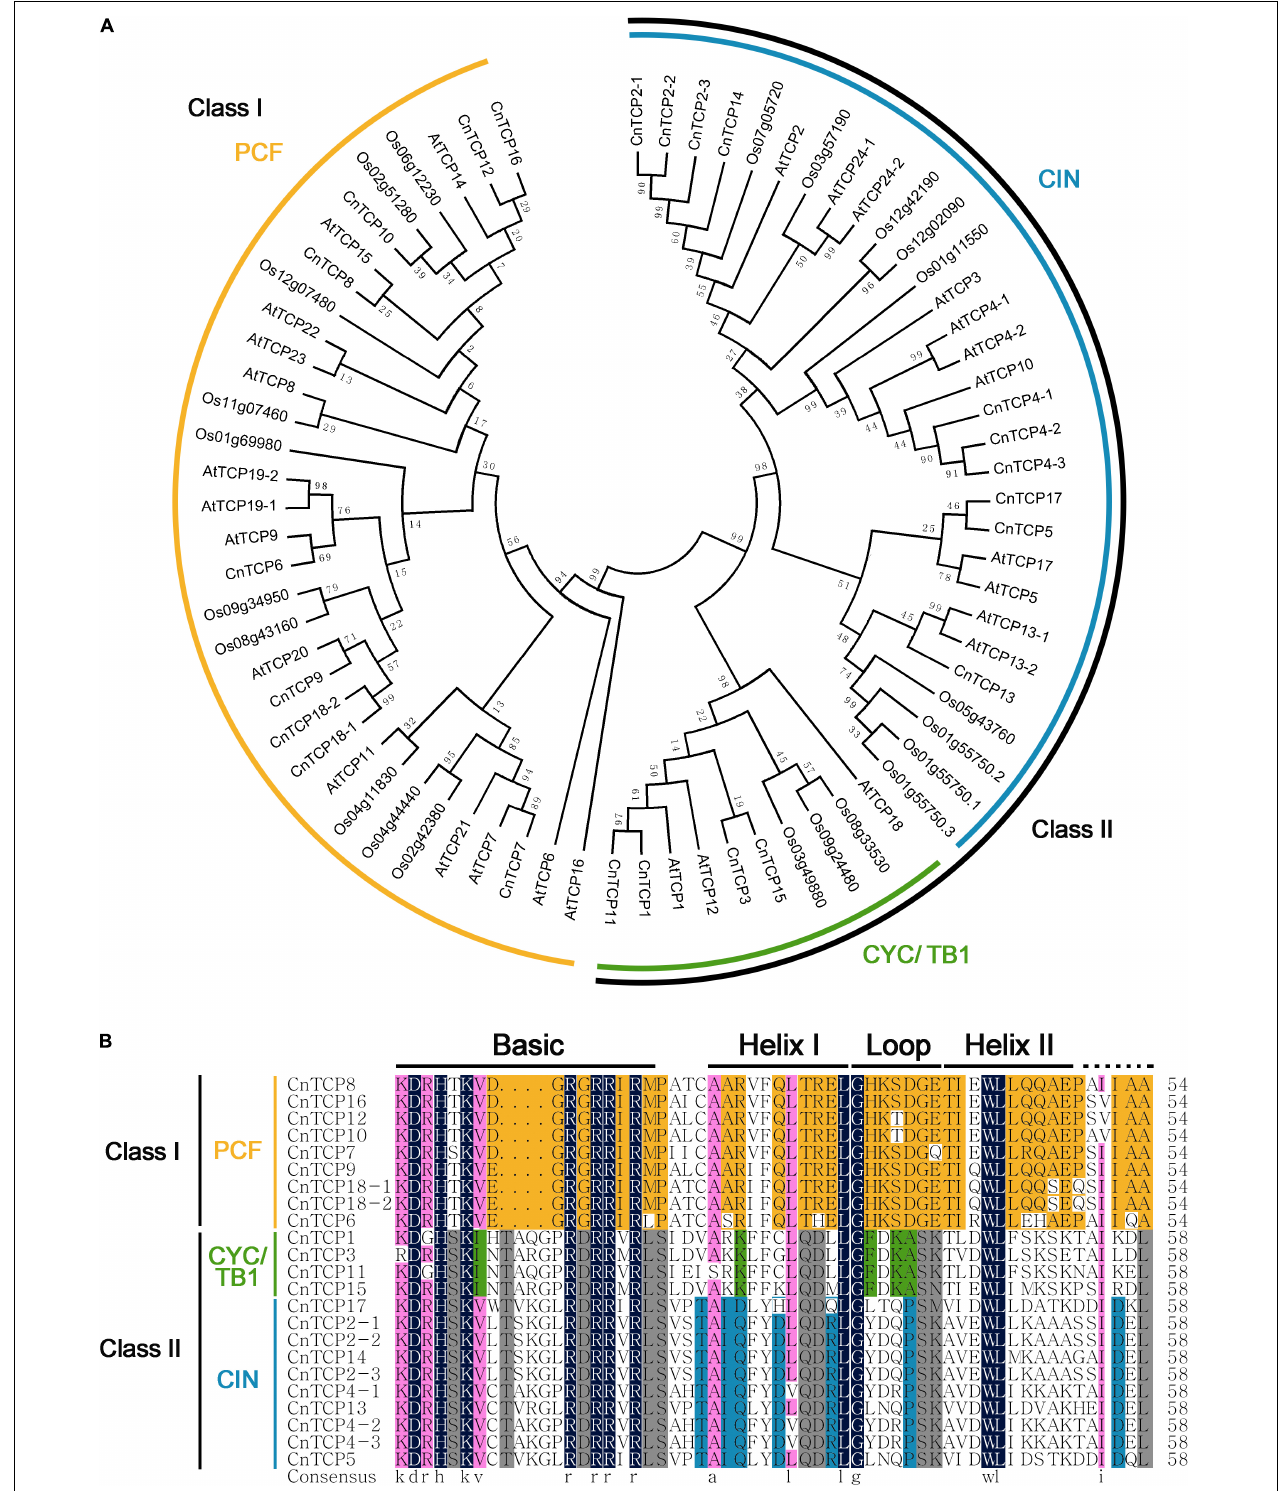
FIGURE 1 | Evolutionary tree and amino acid alignment. (A) The phylogeny of the amino acid sequences from C. nankingense , rice and Arabidopsis TCP family. (B) Alignment of the amino acid sequences from C. nankingense TCP family. Amino acids are expressed in the standard single letter code. Black boxes highlight residues conserved in both TCP classes; yellow, residues conserved in class I; gray, conserved in class II; green, conserved in CYC/TB1 proteins; blue, conserved in CIN-like proteins.